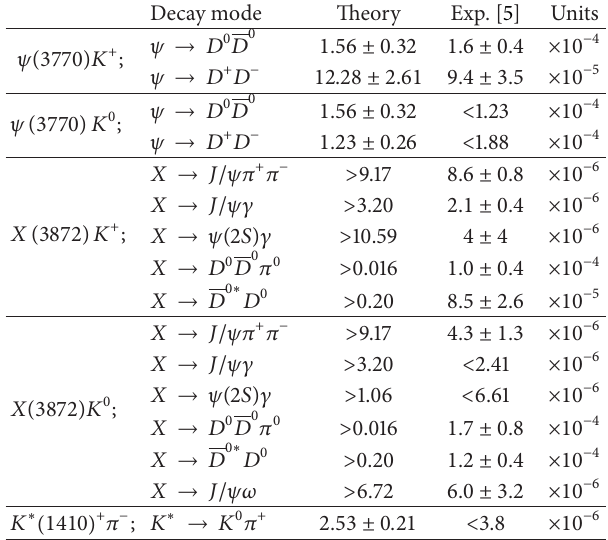
Table 3: Branching ratios of quasi-two-body decays obtained from the studies of three-body decays based on the factorization app-